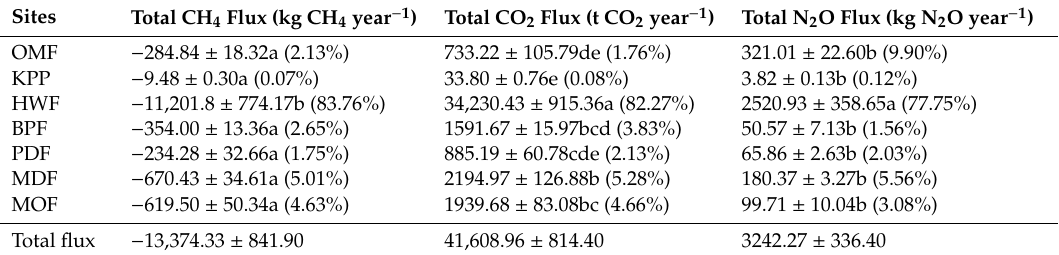
Figure 6. CH 4 fluxes ( a ), CO 2 fluxes ( b ), and N 2 O fluxes ( c ) from the over-mature forest, Korean pine plantation and five secondary forests at the Maoershan Ecosystem Research Station in Northeast China. The lowercase letters indicate statistically significant differences among different treatments. Table 4. Estimation of the cumulative GHG fluxes for each forest type at the Maoershan Ecosystem Research Station in Northeast China. Data are expressed as mean ± SE, n = 3.